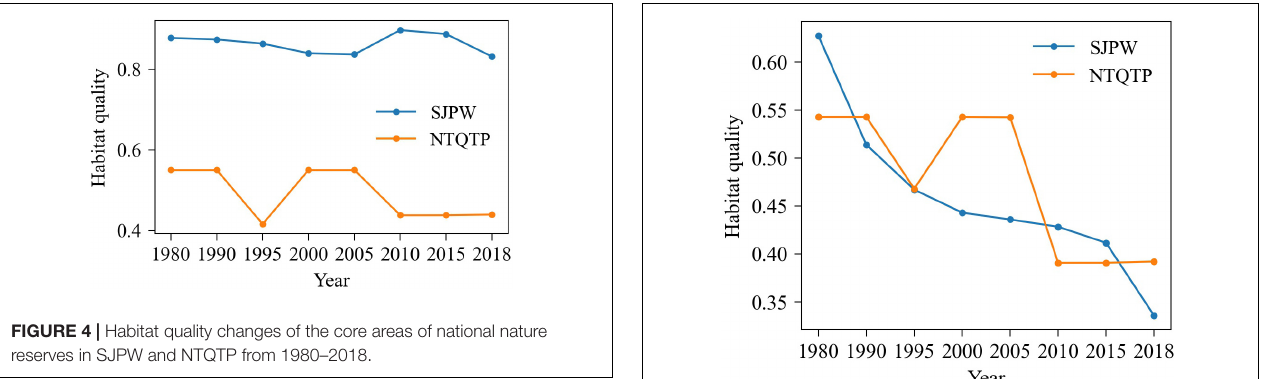
time periods, the biases of SJPW are all negative, except for 1980– 1990. The maximum bias value is − 0.013159 from the period